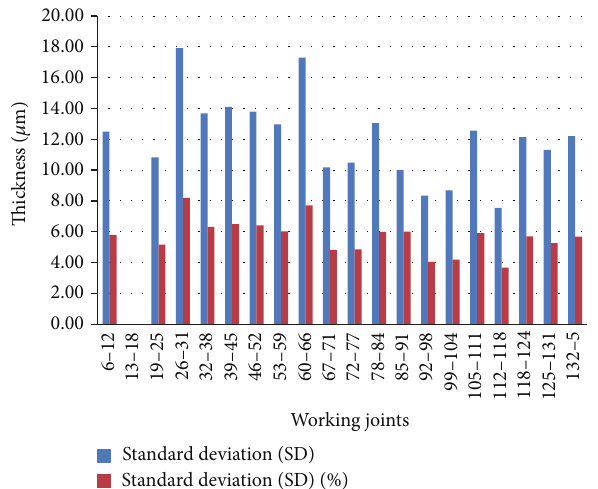
Figure 11: Standard deviation of acrylic emulsion coating on the surface of external shell.